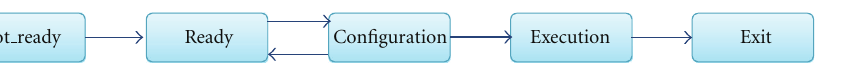
Figure 5: Life cycle states of a